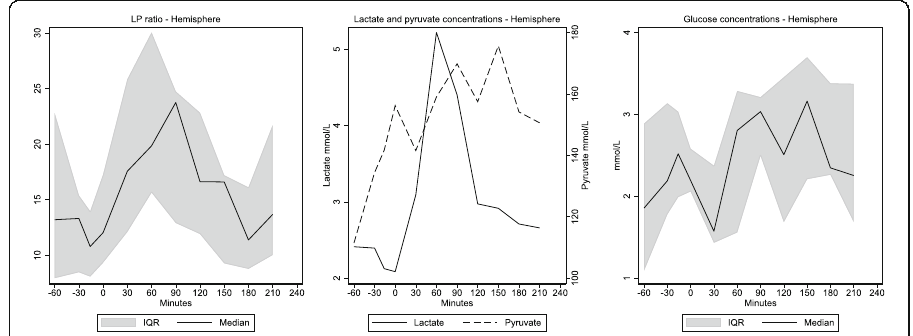
Fig. 4 Reversible metabolic perturbation. 60 min hypoperfusion. LP ratio and microdialysis levels of lactate, pyruvate, and glucose (median (interquartile range)) in brain parenchyma doing hemorrhagic shock in pigs ( n = 9). Note that LP-ratio increases doing hemorrhagic shock but tends to normalize after re-infusion of blood. The rise of LP ratio is due to an increase in lactate levels whereas pyruvate shows a less pronounced elevation. Time 0 indicates achievement of MAP equal to 40